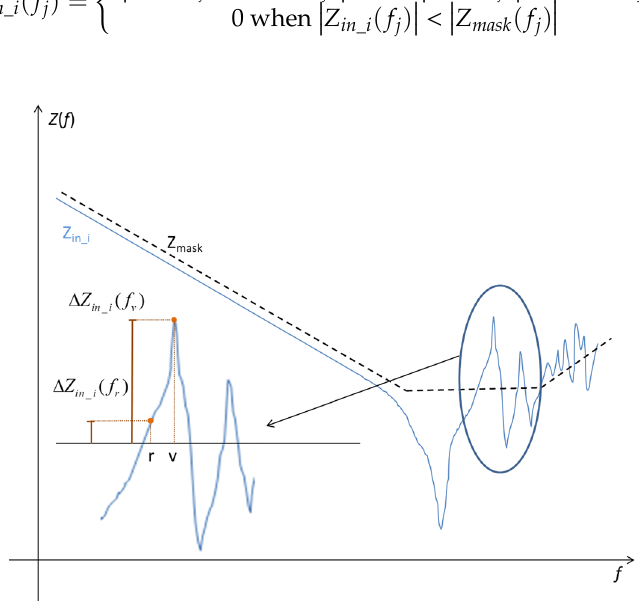
Figure 2. Graphical interpretation of Equation (3).